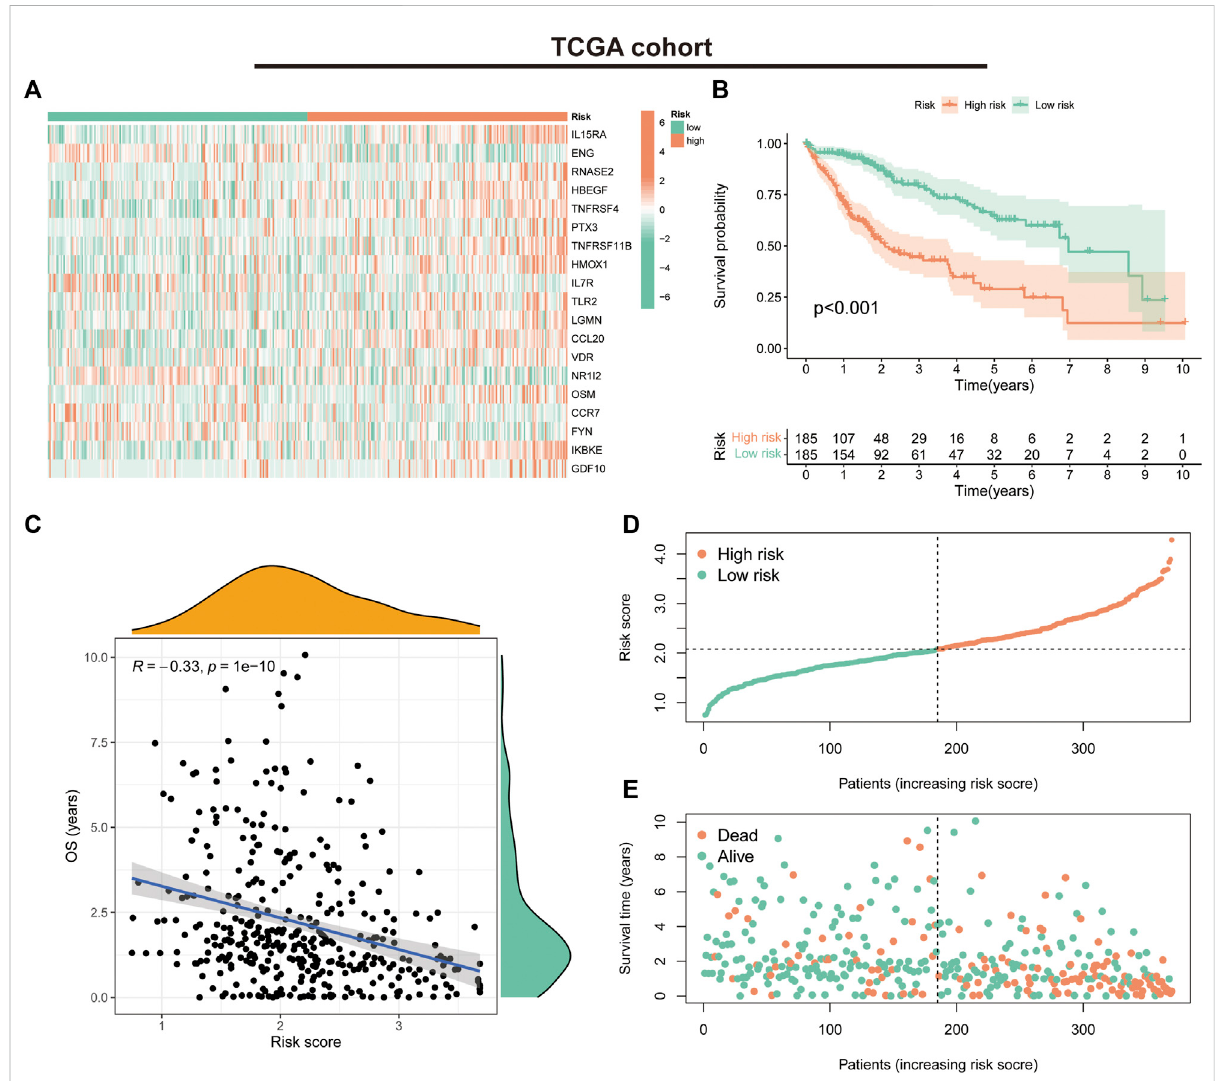
FIGURE 4 Prognostic values of the immune-related gene signature in The Cancer Genome Atlas (TCGA) cohort. (A) Heat map showing expression levels of the 19 immune-related genes in the TCGA cohort. (B) Kaplan – Meier curve for overall survival (OS) in the TCGA cohort. (C) Scatter plot of correlation between risk score and OS in the TCGA cohort. (D) Risk score distribution in the TCGA cohort. (E) Survival time and status in the TCGA